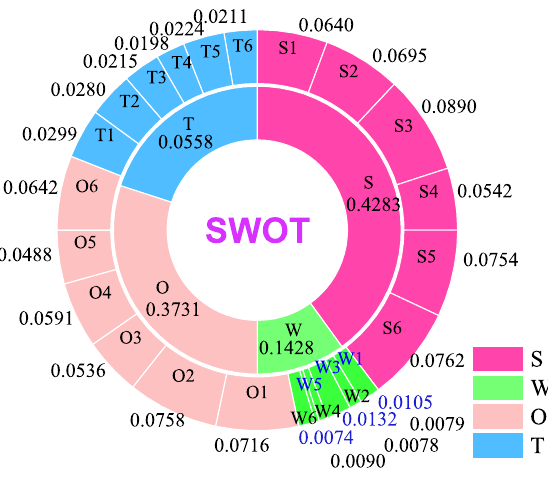
Figure 5. Weight distribution of the SWOT dimensions and factors.